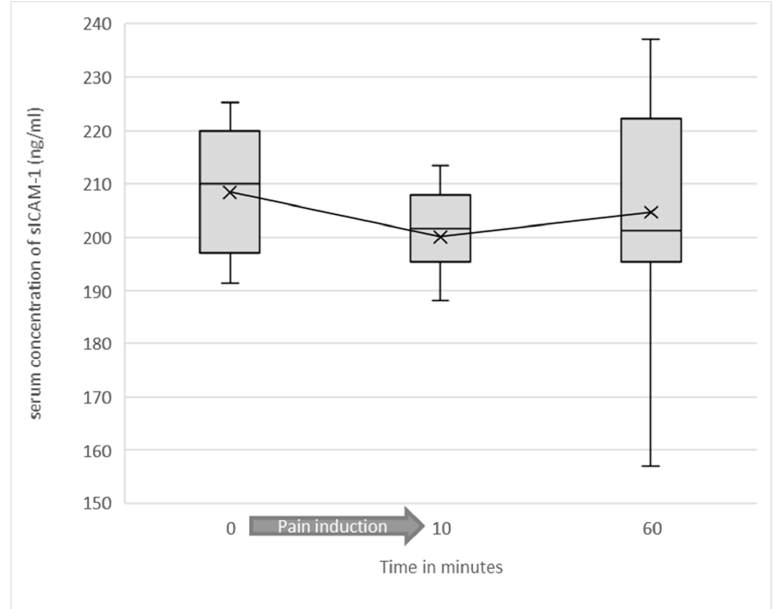
Figure 3. Soluble ICAM-1 serum concentrations as a function of test duration in the low-intensity heat pain group are shown as a box plot diagram. Outliers are not shown. The difference in sICAM-1 concentration before and immediately after heat induction was statistically significant ( p =